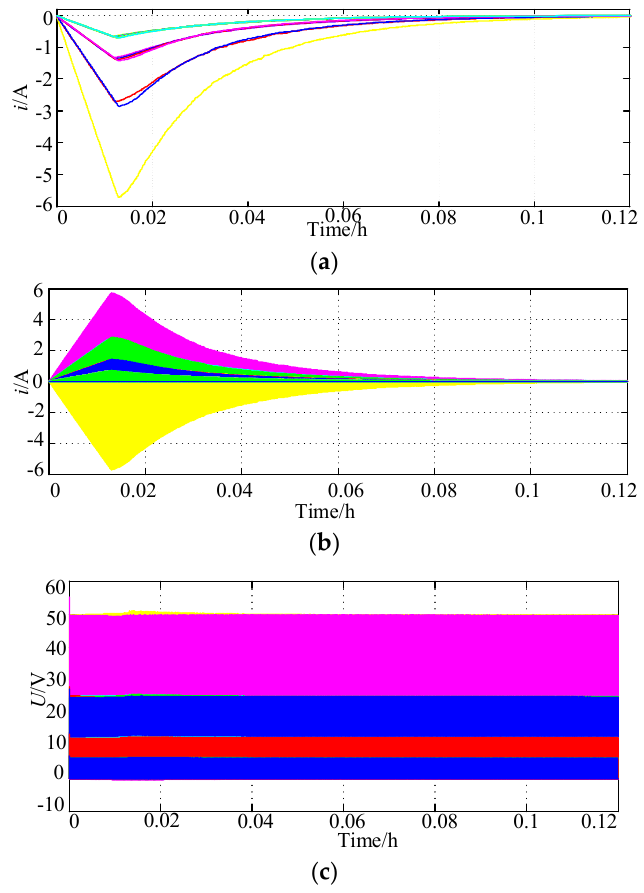
Figure 10. Key waveforms of the layer-based equalisation scheme in the discharging process of U 1 . ( a ) The current of L 1 and the driving signal of S 1 ; ( b ) The current of L 1 , U 2 , U 3 , and U 4 . ( c ) voltage of the